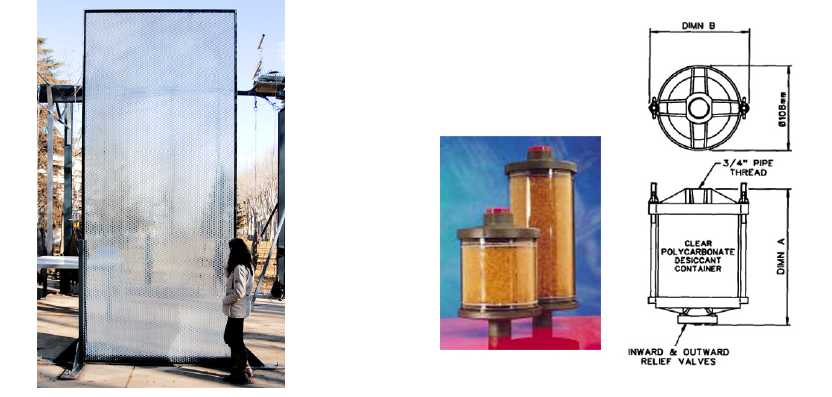
Figure 4: Glass-HC panel measuring 4.60 x 1.90 m. Figure 5: